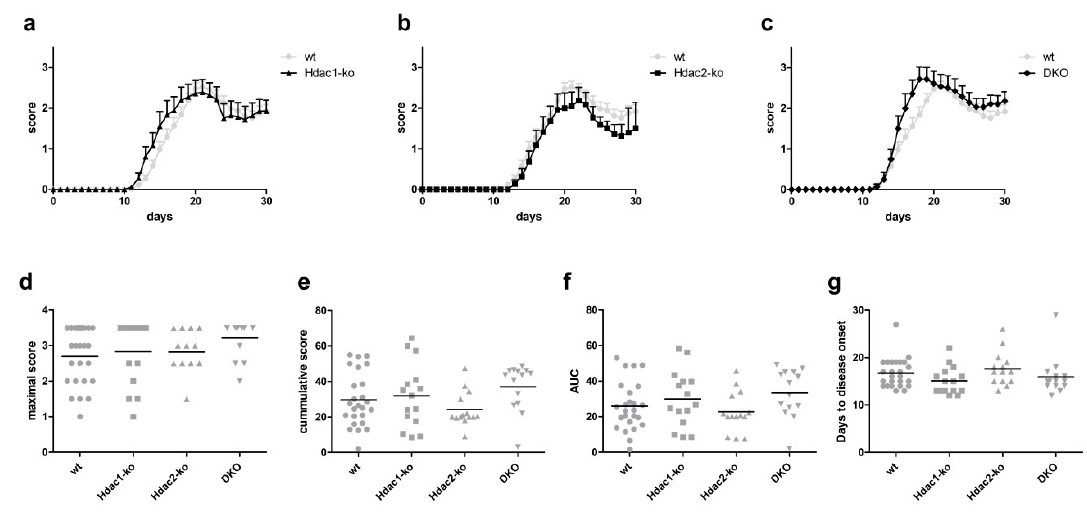
Figure 1. ( a – c ) Experimental autoimmune encephalomyelitis (EAE) disease course in Hdac1-ko ( a ), Hdac2-ko ( b ) and DKO ( c ) mice compared to wildtype (wt). Error bars depict S.D. ( d ) Maximal disease scores in Hdac1-ko, Hdac2-ko, DKO and wt mice. ( e ) Cumulative disease scores in Hdac1-ko, Hdac2-ko, DKO and wt mice. ( f ) Area under the curve for disease course for each animal by genotype. ( g ) Days to disease onset for each animal. No statistical difference at any time point was found. The numbers of animals analyzed were 25 (wt), 15 (Hdac1-ko), 14 (Hdac2-ko) and 14 (DKO).